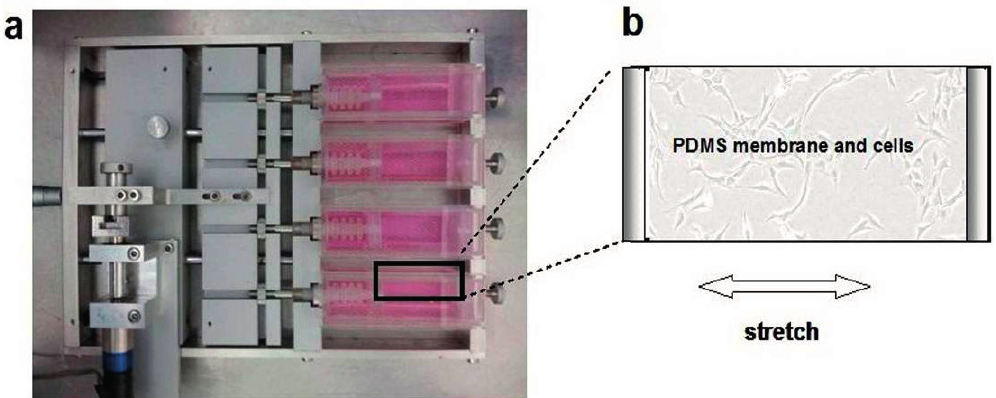
Figure 6. The uniaxial CS was applied to the vaginal fibroblasts via the PDMS membrane fixed in-house of the cell stretching device ( a ); Vaginal fibroblasts sub-cultured on the PDMS membrane ( b ). Arrow indicates the stretching